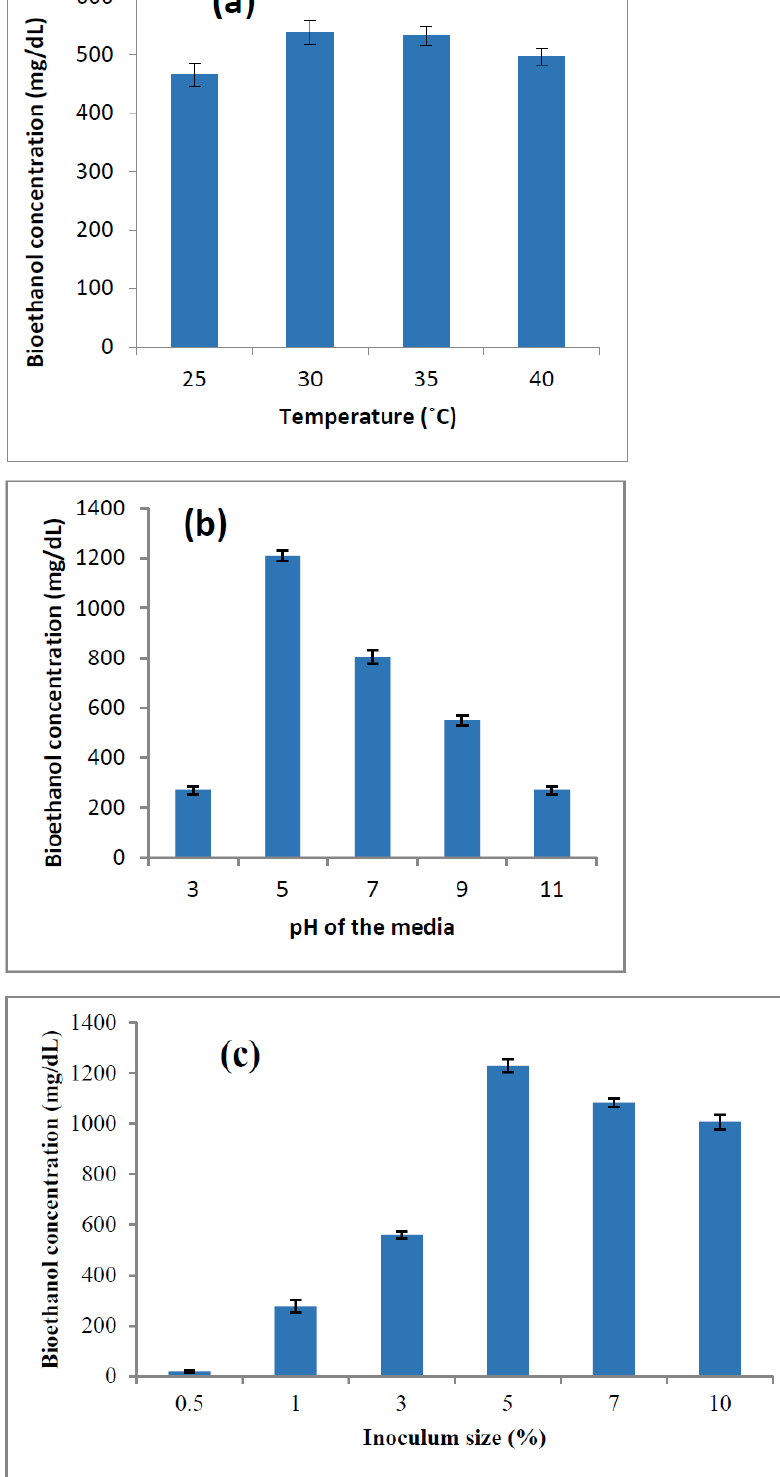
Figure 9. Effect of ( a ) incubation temperature, ( b ) pH of the media, and ( c ) inoculum size on the bioethanol concentration using the isolated yeast strains.